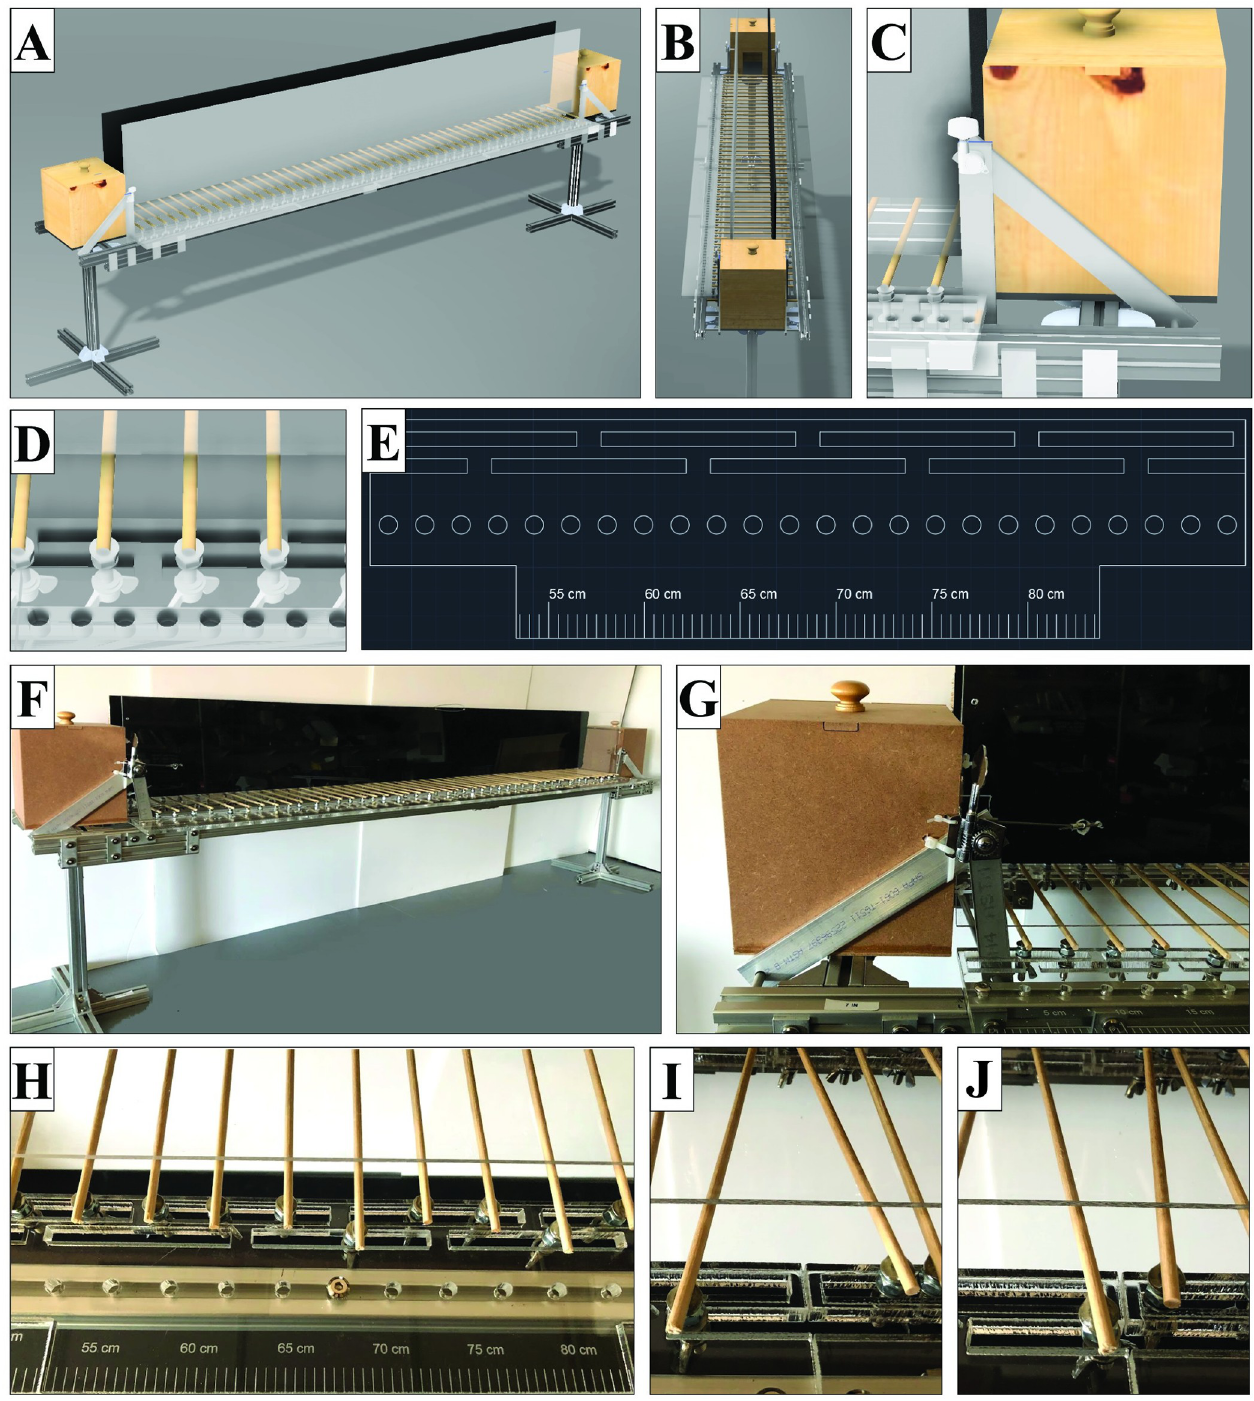
Fig 1. CAD and construction of the modular asymmetrical ladder. (A) A CAD (computer-aided design) rendering of the complete ladder. (B) A longitudinal projection of the CAD rendering. (C) A close-up CAD rendering of the wall tensioning mechanism. (D) A close-up CAD rendering of the rung adjustment mechanism. (E) A 2D CAD image used for laser cutting of the rung adjustment mechanism. (F) The actual complete ladder after fabrication. (G) A close-up of the actual wall tensioning mechanism. (H) A close-up of the actual rung adjustment mechanism with etched measurement marks. (I, J) A demonstration of the adjustment and angling of the ladder